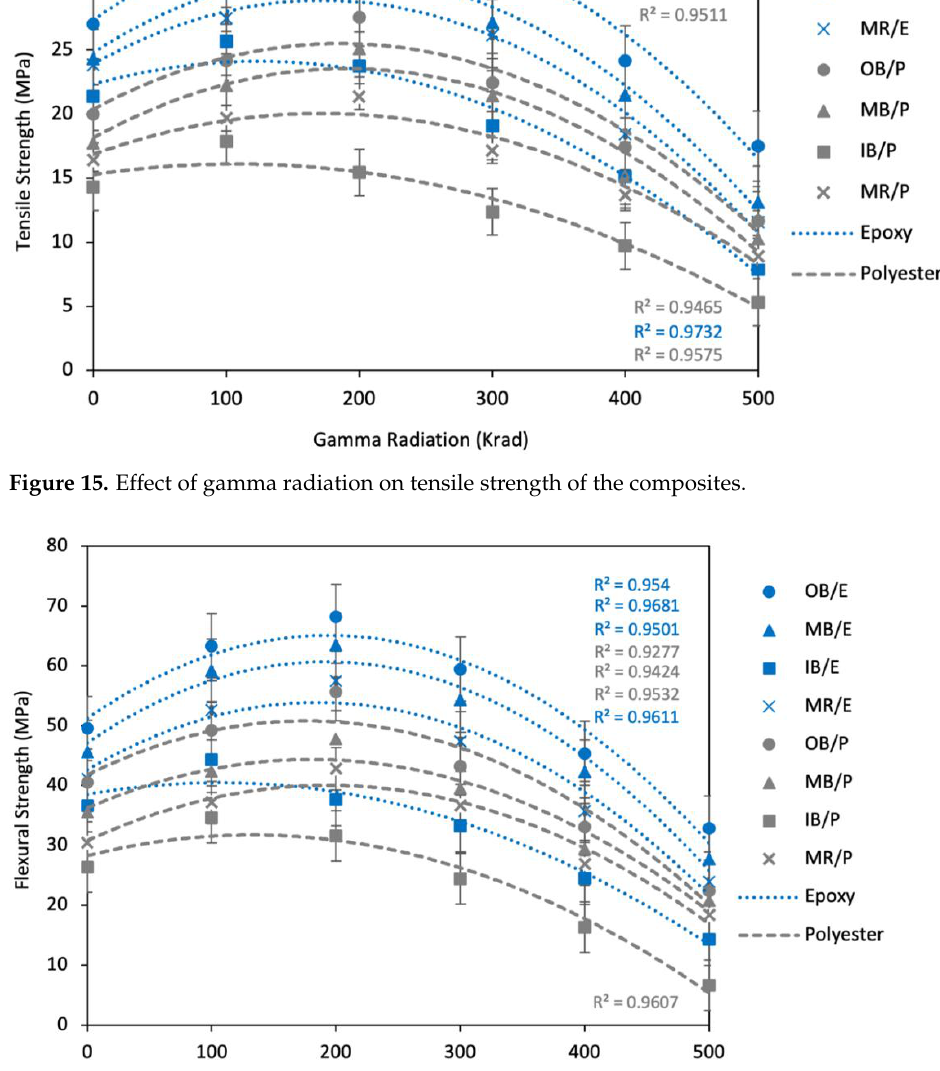
Figure 17. Effect of gamma radiation on elongation at break (%) of the composites.